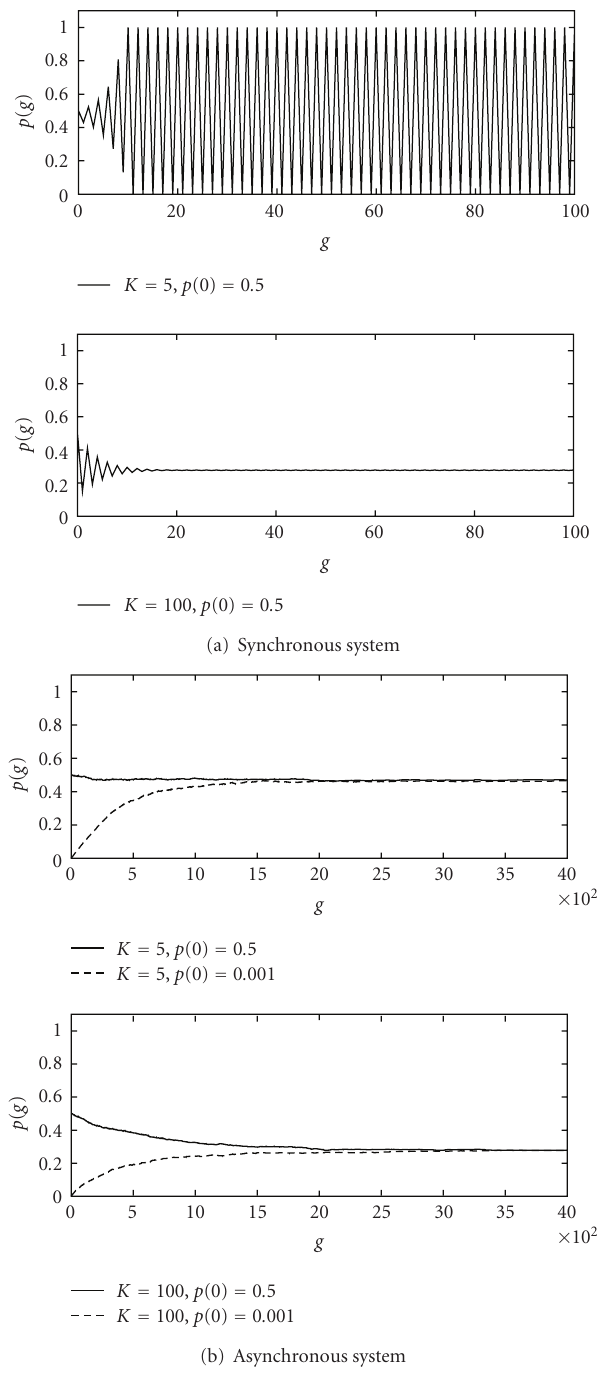
Figure 5: Transient behavior (full-mesh